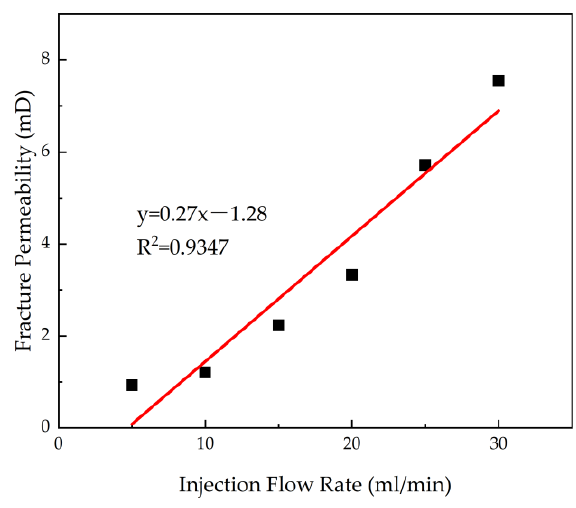
Figure 16. Influence of injection flow rate on the permeability